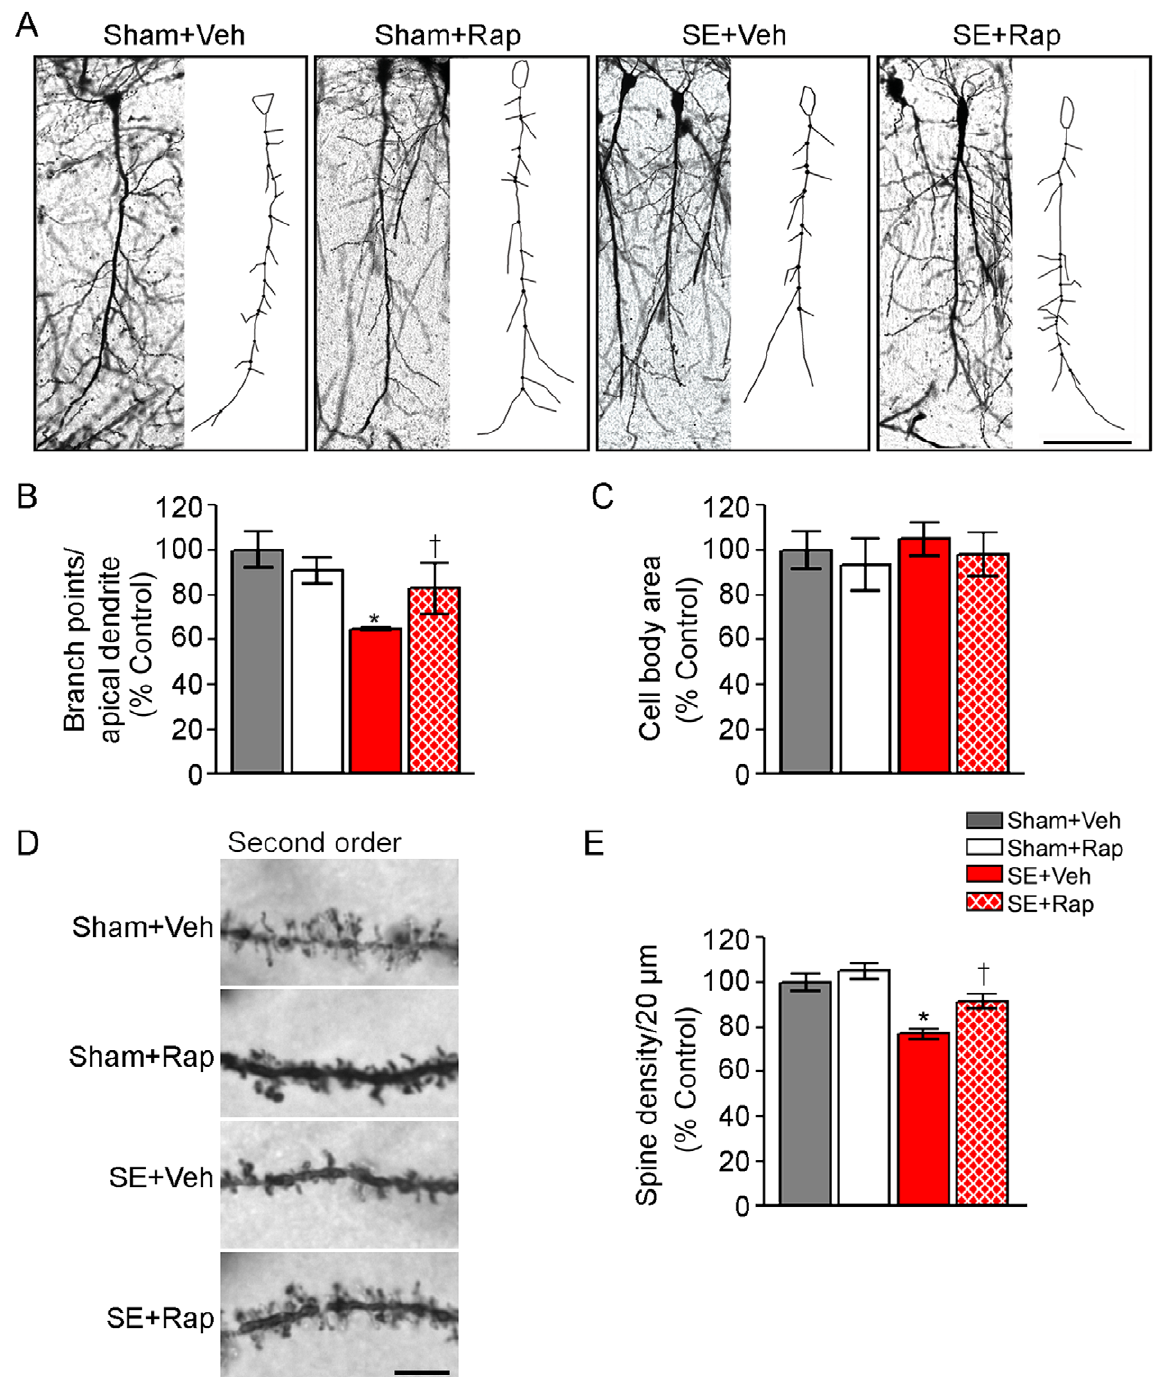
Figure 8. Rapamycin improved CA1 dendritic arborization and spine density in hippocampi from rats subjected to SE. We used golgi staining followed by neurolucida reconstructions to determine dendritic branching and spine density in CA1 cells from SE and sham rats after treatment with rapamycin (Rap) or vehicle (Veh) following the behavioral tests. ( A ) Representative images of golgi-stained CA1 neurons and their respective reconstructions showing the branch points from the apical dendrites. ( B ) Branch point analysis normalized to percent of Sham + Veh (% control) shows a significant decrease in the apical dendrite branch points in the SE + Veh compared to the Sham + Veh group that is reversed in the SE + Rap group; n=4 2 6 brains/group from which 4–17 cells/brain were analyzed. ( C ) Analysis of cell body area shows no differences between the groups. ( D ) Representative images of 20 m m sections of second order dendritic branches and spines; n=59 2 80 branches/group. ( E ) Quantitative analysis of spine density in secondary dendritic branch structures shows a significant decrease in spine density from the SE + Veh compared to the Sham + Veh group that is reversed in the SE + Rap group. Scale bar= A : 100 m m; D : 5 m m. * compared to Sham + Veh, P , 0.05; { compared to SE + Veh, P , 0.05, ANOVA with Tukey’s post hoc test. Error bars=SEM.